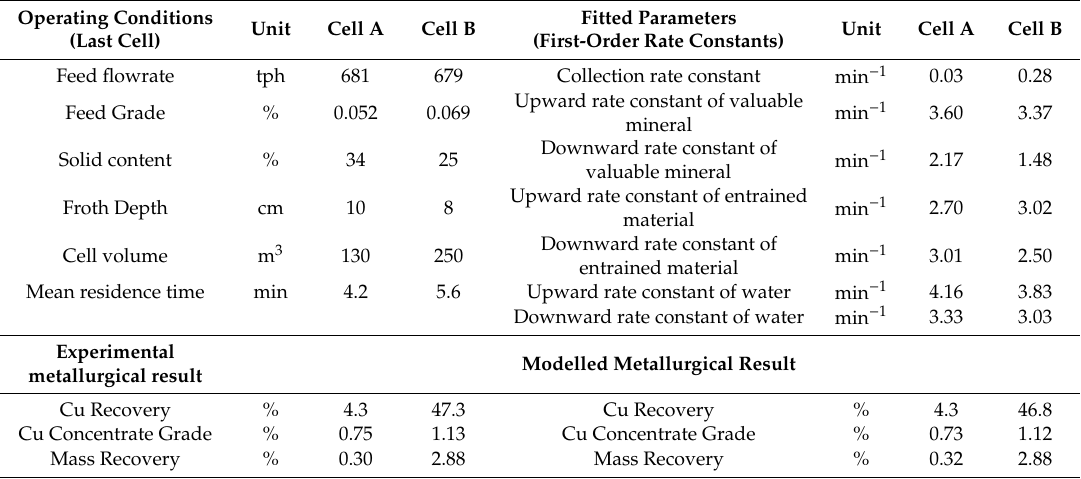
Table 1. Operating conditions, fitted parameters and metallurgical results in the last cell of circuits A and